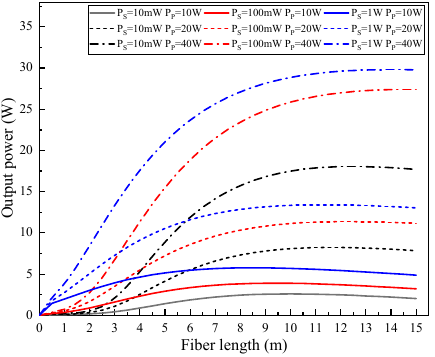
Figure 1. Numerical calculation of the dependence of the amplified output power on the fiber length at different pump and signal powers.